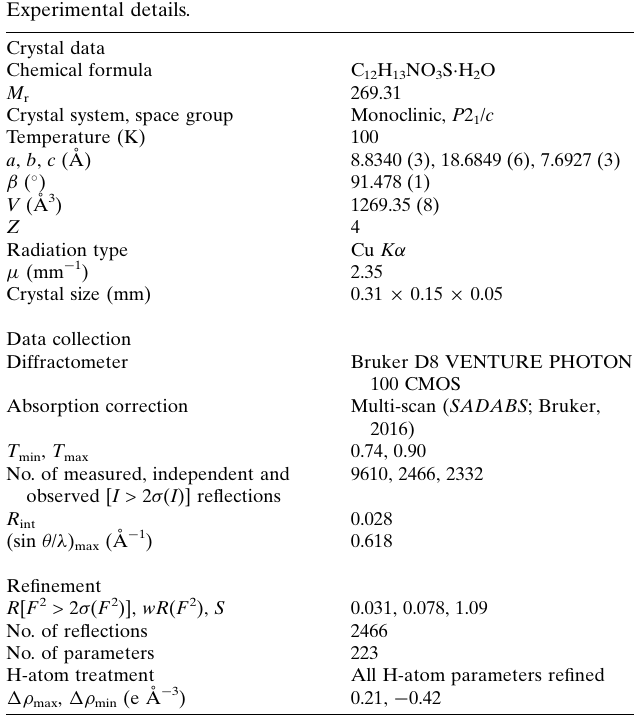
Table 2 Experimental details.